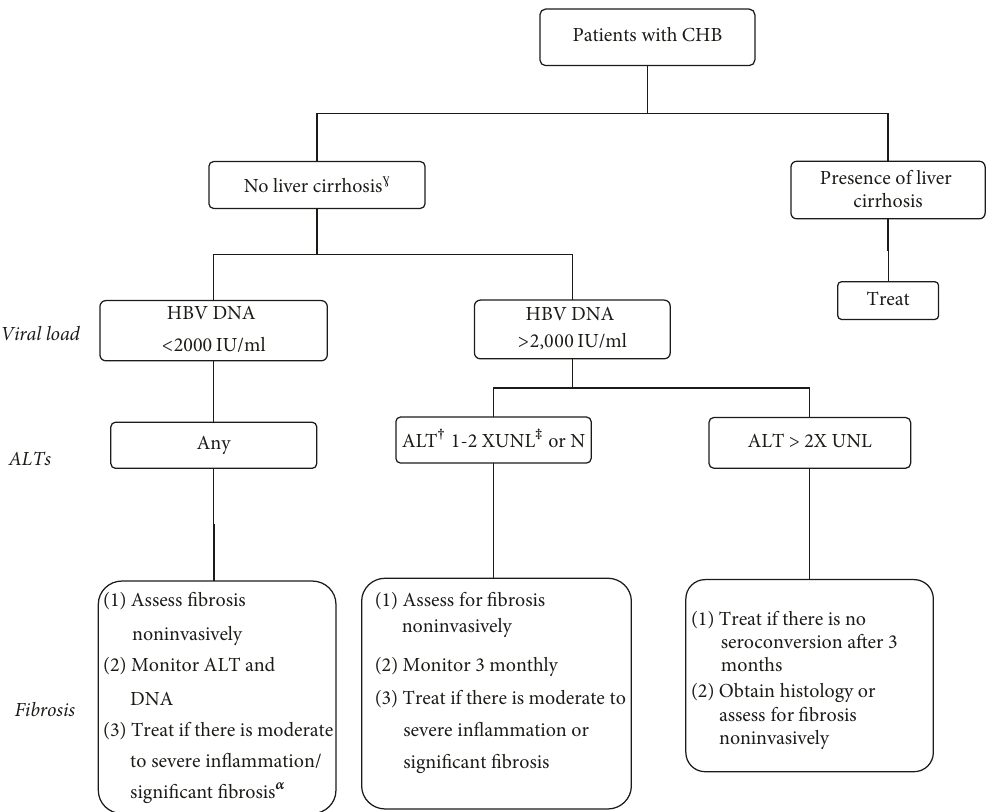
Figure1:IndicationsforstartingthetreatmentinpatientswithchronichepatitisBvirusinfection[1]. † ALT:AlanineAminotransferase. ‡ UNL: upper normal limit. ULN is 30 U/L for men and 19U/L for females. 훼 Significant fibrosis is defined by liver stiffness ≥ 8kPa (by Fibroscan) or [AST]-to-platelet ratio index (APRI) ≥ 1.5. › Liver cirrhosis is determined by liver stiffness ≥ 11kPa (by Fibroscan) or APRI ≥